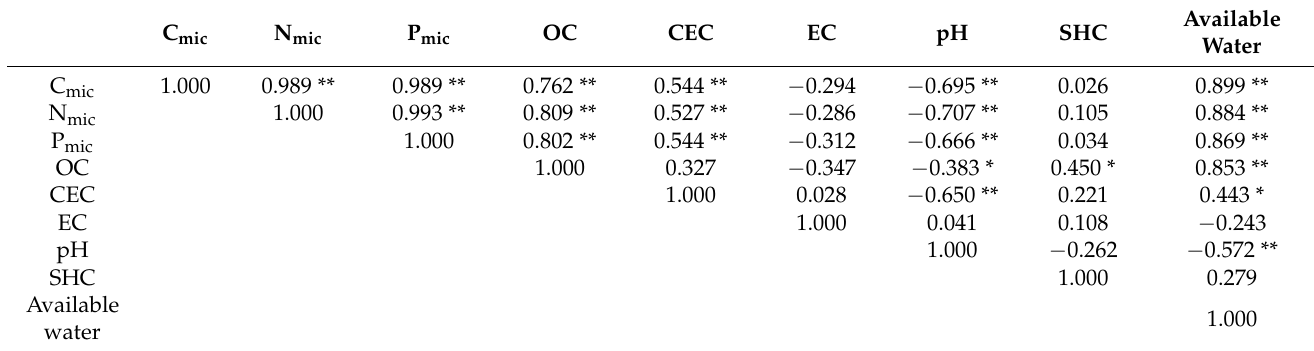
Table 3. Correlation coefficient ®between soil C mic , N mic , and P mic and other soil